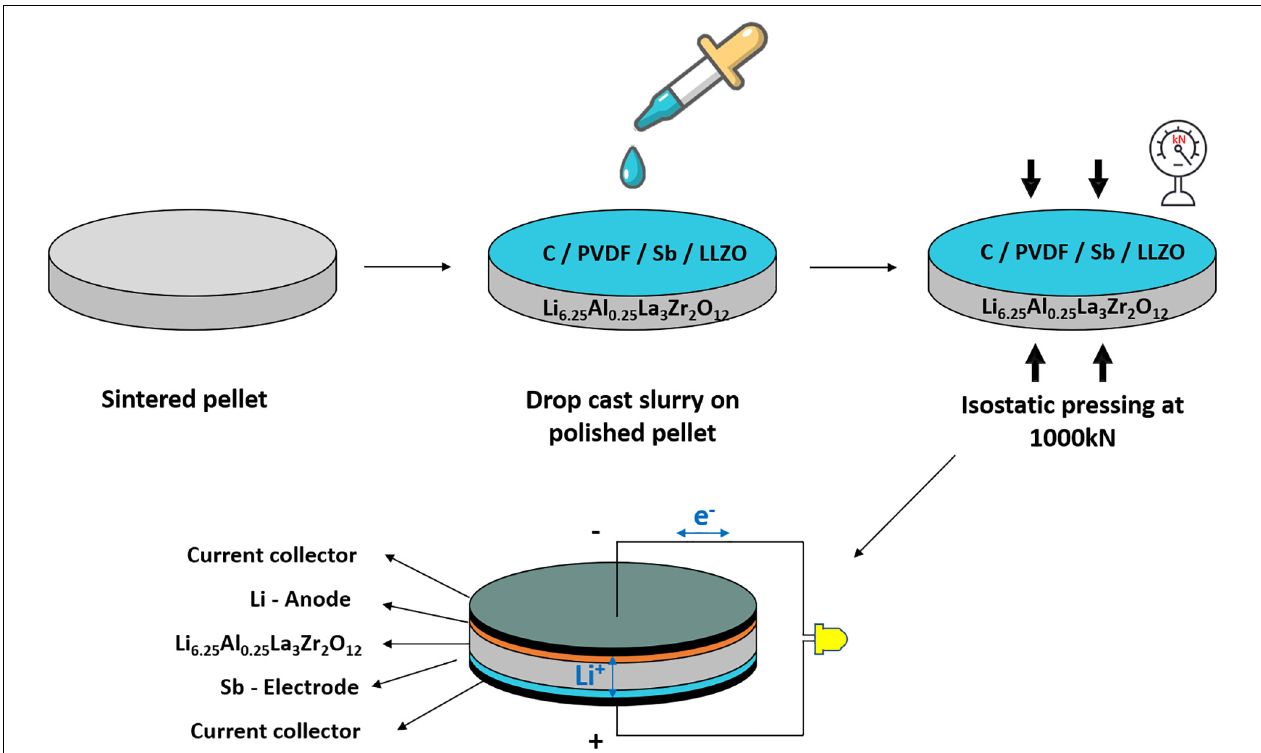
FIGURE 4 | Schematic image showing the deposition of the electrode to prepare an all-solid-state battery. Reprinted with permission from reference Afyon et al. (2019). Copyright 2019 Royal Society of Chemistry.